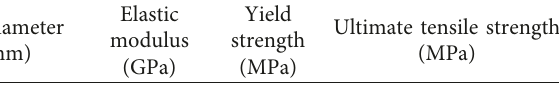
Table 1: Different sizes of quartz sand used in experiment. Quartz sand Grain size Coarse sand Medium sand Fine sand Mesh number Table 2: Mechanical parameters of bolt. Diameter